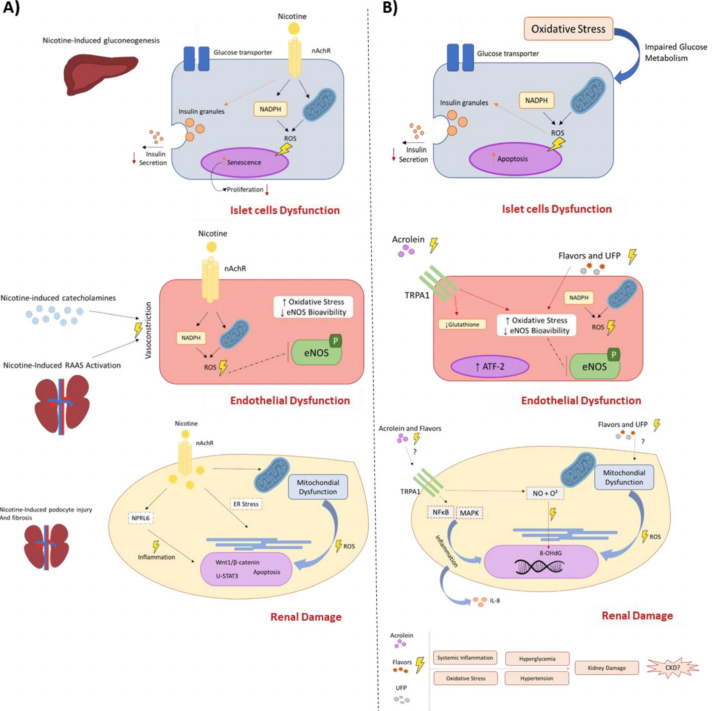
Figure 1. Potential cellular and molecular mechanism triggered by nicotine and compounds generated by ENDS and their role on CKD pathophysiology. ENDS release several chemical compounds, including nicotine, ultrafine particles, flavoring, and other harmful and potentially harmful constituents generated by thermal degradation. Thus, these compounds are absorbed by the lungs and reach systemic circulation to exert their toxicity and favor the onset of CKD and its related disorders. Although the harmful and direct effects of nicotine are well known and reported in clinical and experimental studies ( A ), other xenobiotics released by ENDS, such as acrolein, ultrafine particles (UFP), and flavorings possess the potential to trigger deleterious effects, leading to cumulative damages and favor CKD onset ( B ), however further data are required. The direct interaction of tobacco-released compounds with the endothelium increase reactive oxygen species (ROS), decreases endothelial nitric oxide species (eNOS) [73,74,126–129,170] and leads to an inflammatory response mediated or not by nicotinic receptor activation (nAChRs) or stress sensors receptors (TRPA1) [75,123–125,146,147], evoking endothelial dysfunction, impaired vascular relaxation, and increasing blood pressure. Directly or indirectly, these xenobiotics can impair glucose metabolism by affecting β islet cell homeostasis [85,86,90] and mitochondrial function in an ROS-dependent manner, culminating in insulin resistance and Diabetes Mellitus type II onset [95,100,135]. Finally, the kidneys are affected by the systemic inflammatory response, increased blood pressure, and higher levels of ROS, which increase mesangial cell proliferation, activate programmed cell death pathways on tubular cells, and impair mitochondrial function [109–115,135–137]. Once the kidneys are responsible for filtration, these xenobiotics accumulate on renal structures and cause inflammation and oxidative stress. Altogether, these mechanisms decrease glomerular filtration rate (GFR) and kidney function, leading to the late establishment of